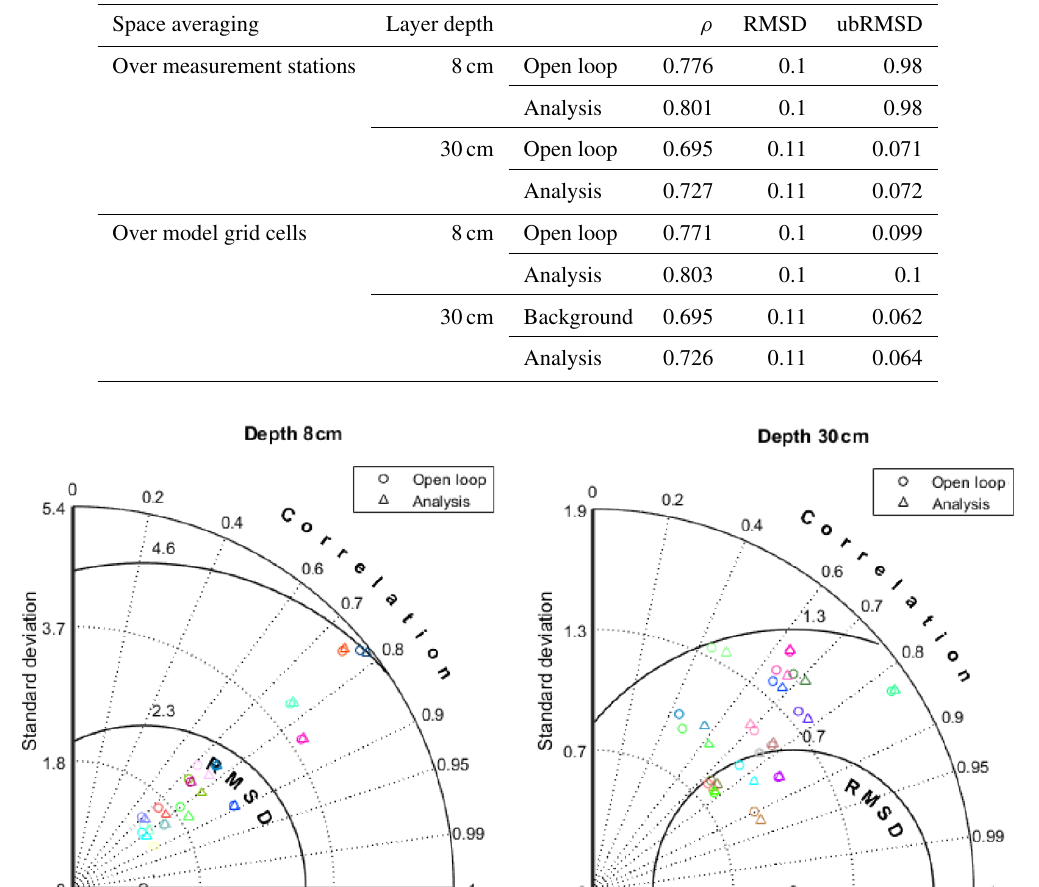
Figure 7. Taylor diagrams (TDs) drawn from the comparison between in situ observed and SFX-simulated (background and analysis) soil moisture for the two different soil